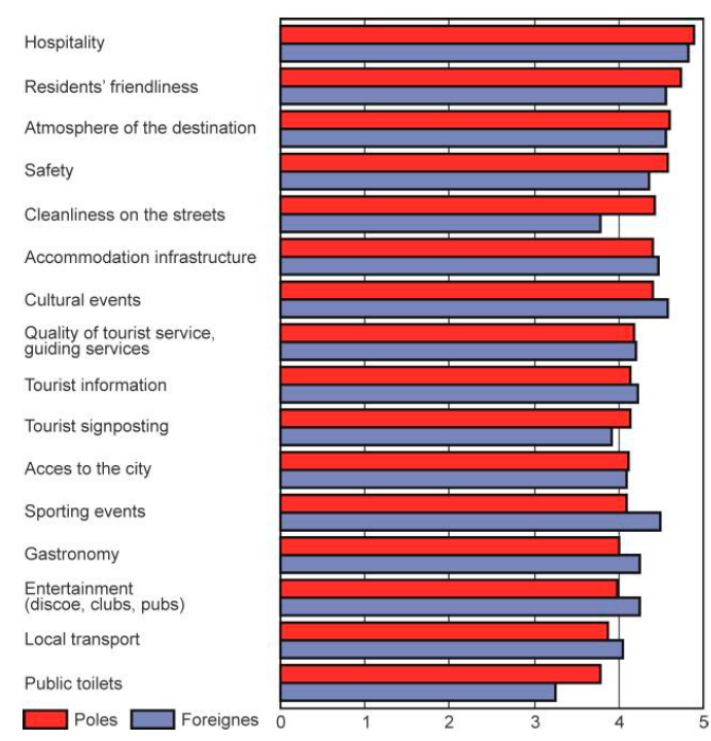
Figure 7. Mean ratings of different aspects of WYD in the Archdiocese of Lodz (1—very bad, 5—very good) (Source: authors, based on a survey).